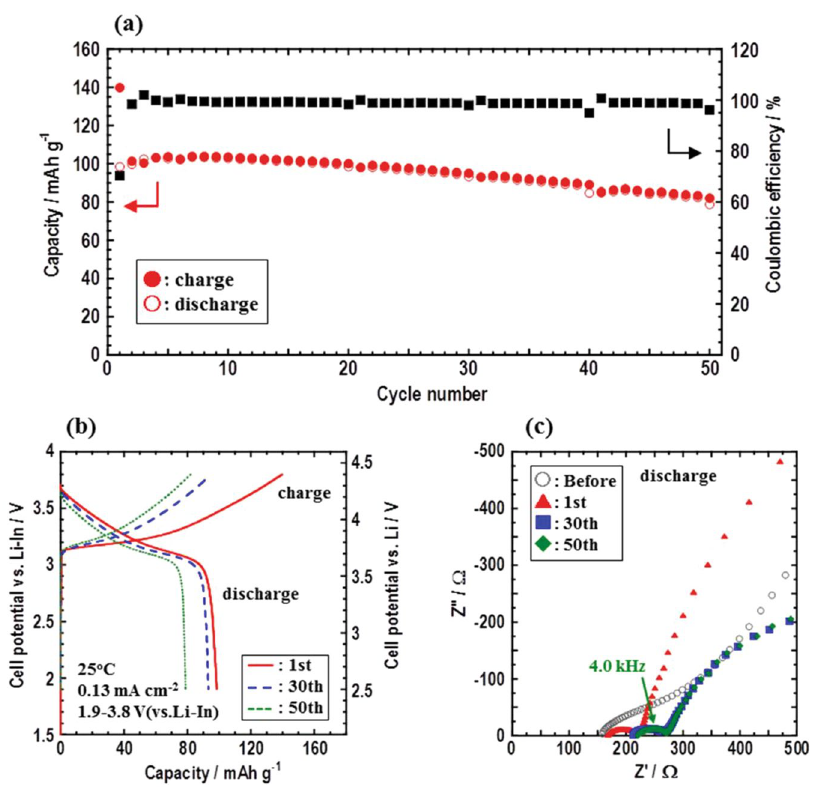
Figure 1. ( a ) Long-term cycle performances of the all-solid-state cell In/LPS/NMC, ( b ) Charge–discharge curves of the cell at 25 °C under a current density of 0.13 mA cm − 2 , and ( c ) Nyquist plots of the cell before charge–discharge and after the 1st, 30th, and 50th discharge